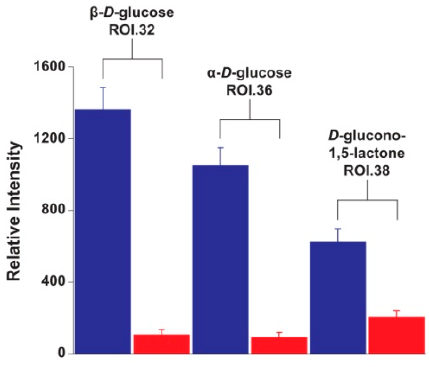
Figure 4. Quantitation of monomeric sugars in D 2 O extracts of Helicoverpa armigera larvae. Quantitation was performed on a single 1 H- 13 C HSQC ROI per metabolite. ROIs with the highest variability according to PCA loadings were selected. Herbivores = blue; cannibal = red.